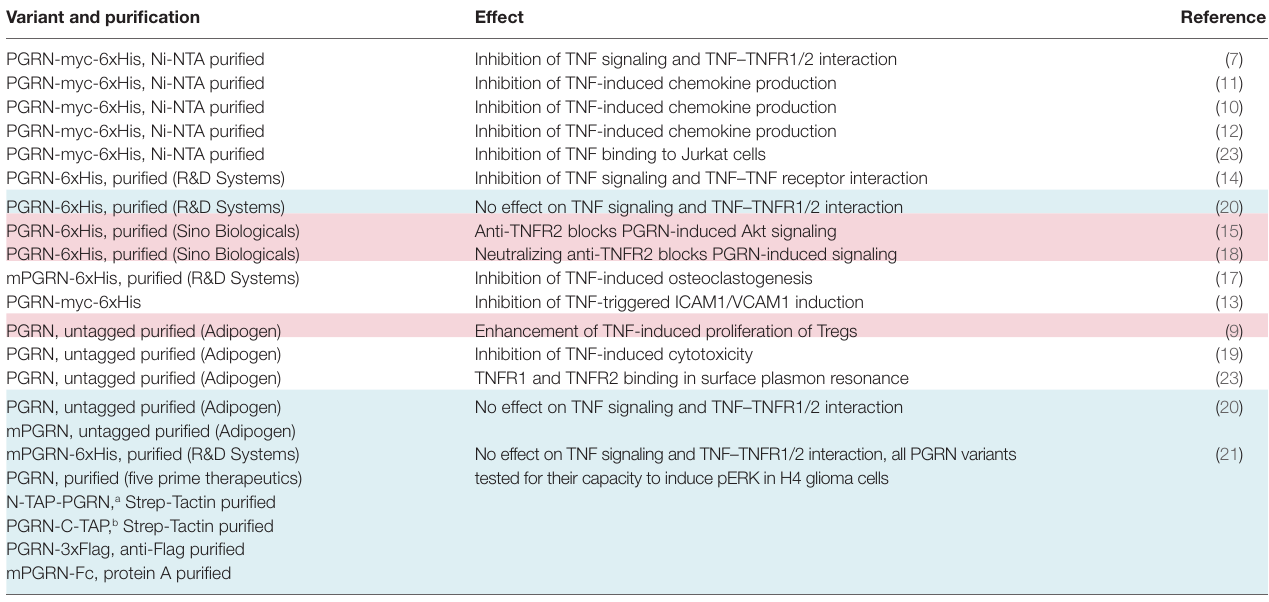
TaBle 1 | Progranulin (PGRN) variants used to study the PGRN-tumor necrosis factor (TNF)